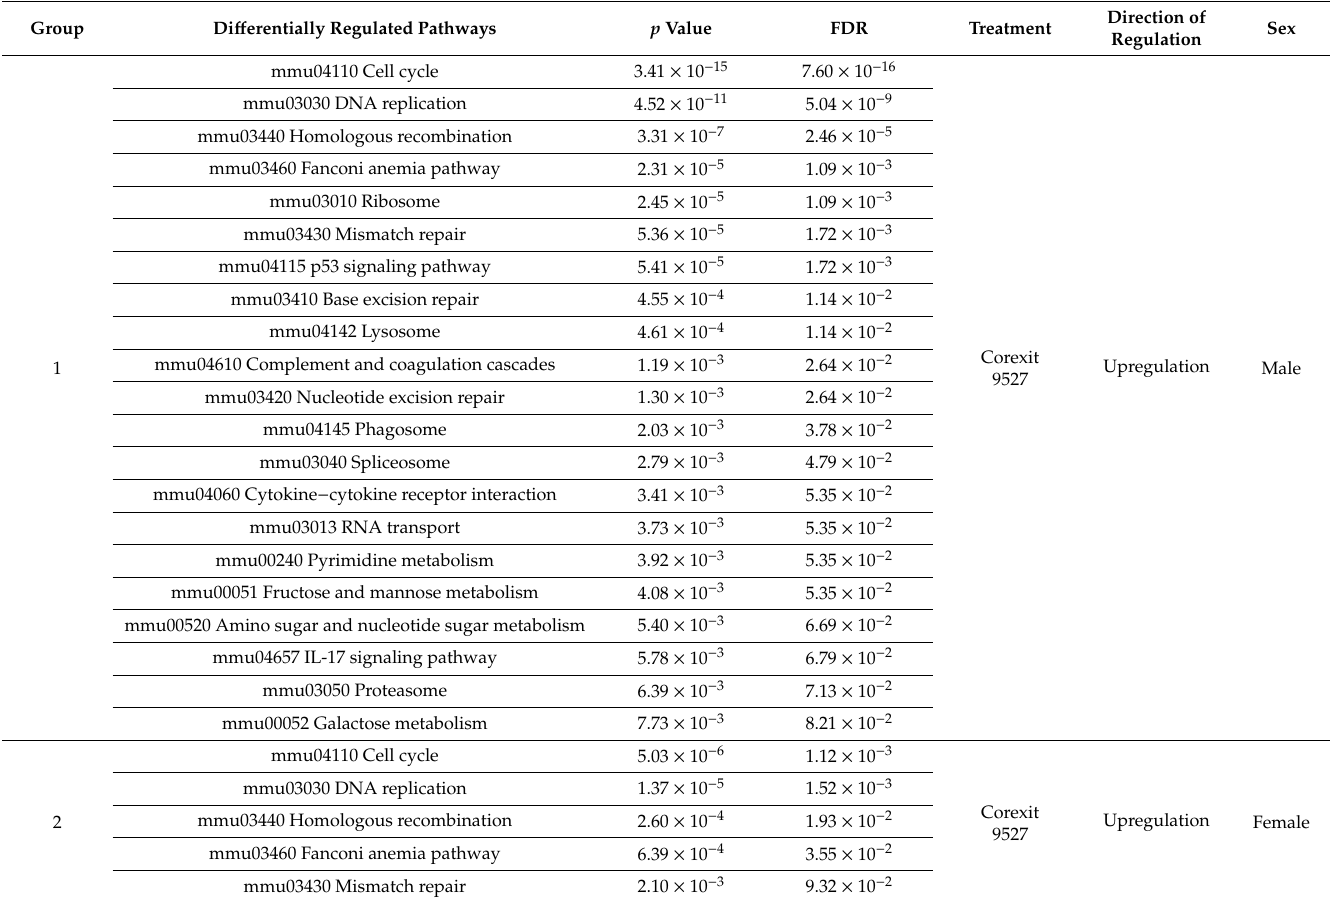
Table 4. Sex-specific analysis for regulation of KEGG